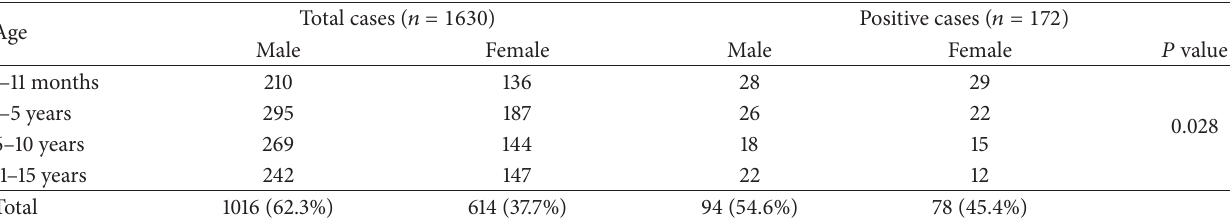
Table 1: Distribution of total and positive cases.